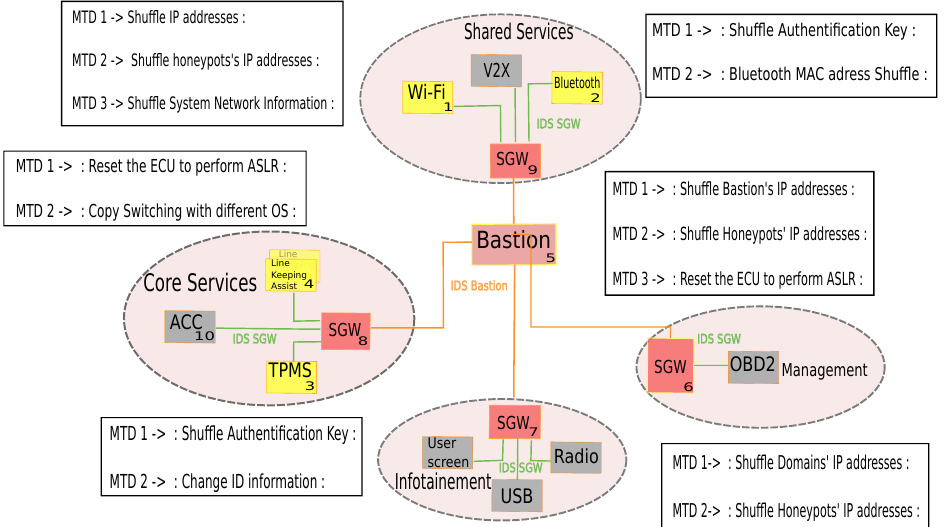
Figure 3. Selected nodes and their